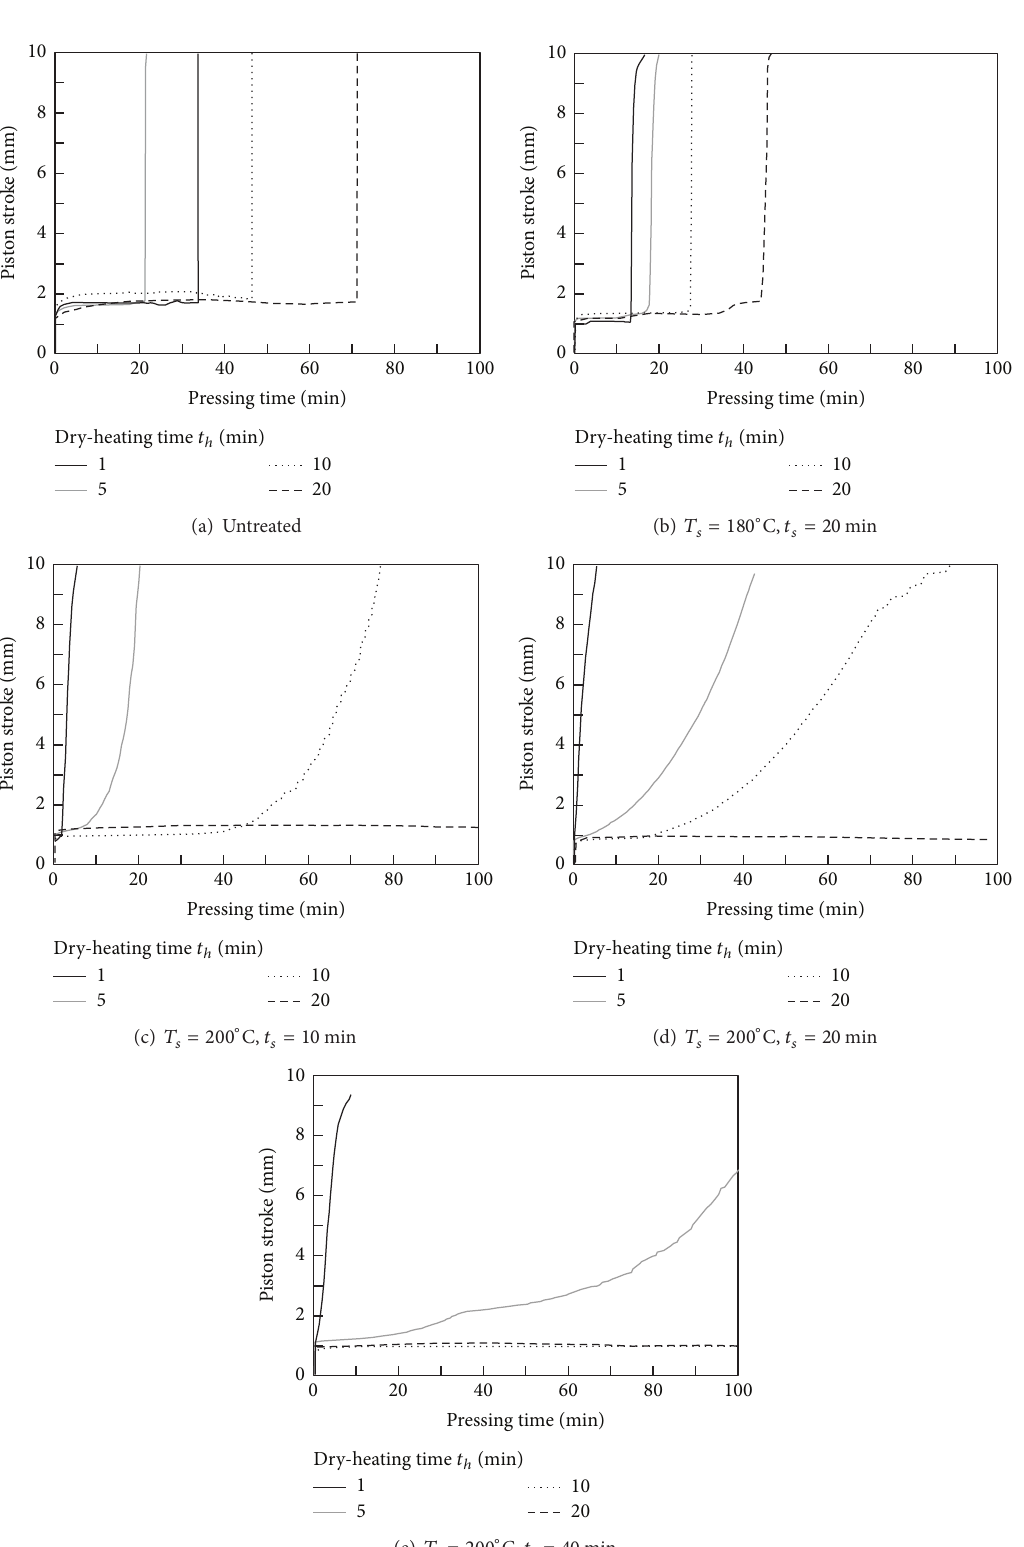
Figure 7: Effect of dry-heating time 𝑡 ℎ on the thermal flow curve when the steam treatment temperature is